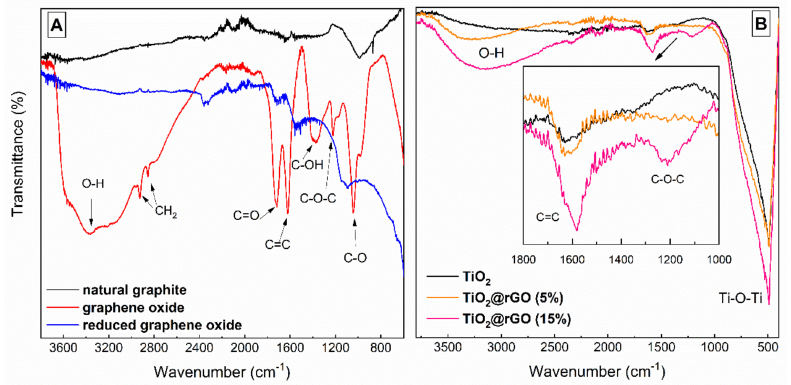
Figure 1. FTIR spectra of ( A ) natural graphite, GO, rGO; ( B ) TiO 2 and TiO 2 @rGO nanocomposites prepared with different amounts of GO (5 wt.% and 15